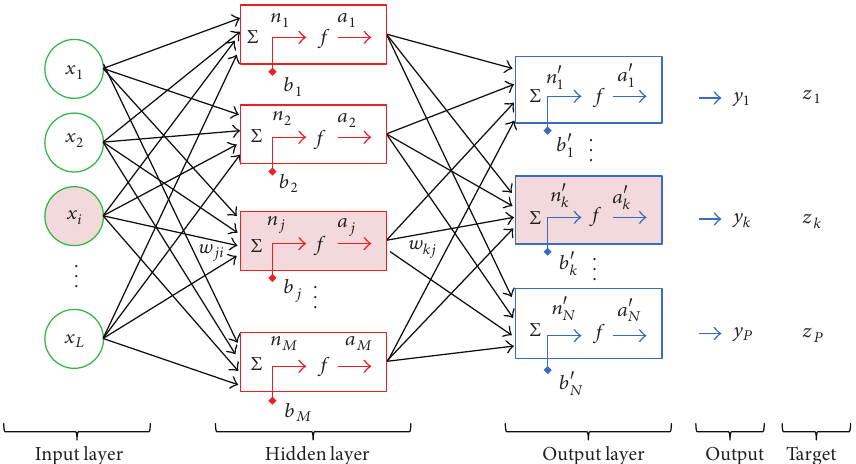
Figure 1: Schematic representation of a multilayer feed forward (MLP) network showing activity levels generated by the neurons in different